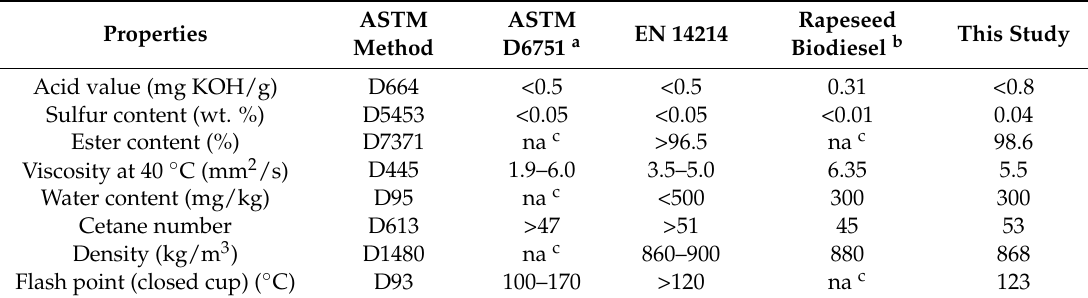
Table 3. Soursop biodiesel’s properties compared with those of rapeseed biodiesel, the standards ASTM D6751, and EN